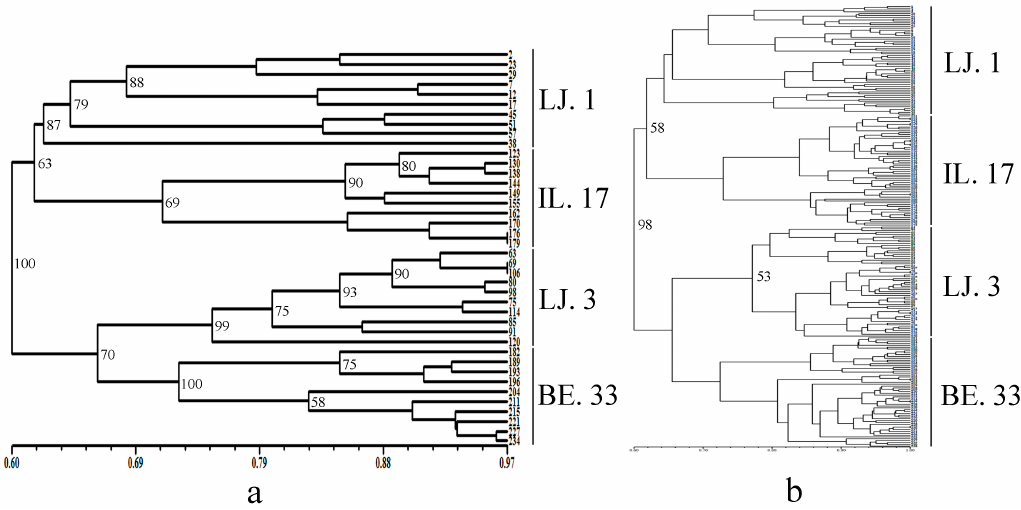
Figure 2. The Unweighted Pair Group Method with Arithmetic Mean (UPGMA) dendrogram of common vetch based on Jaccard’s genetic similarity; only bootstrap values higher than 50% are presented. ( a ) Forty individuals of four germplasm; ( b ) 240 individuals of four germplasm and the genetic distance of start codon targeted (SCoT) markers.